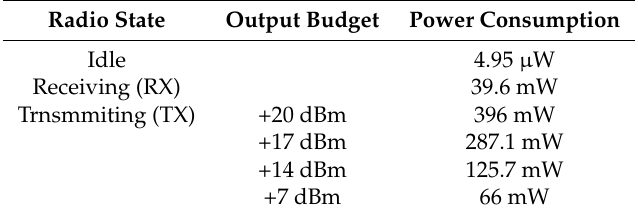
Table 8. Energy Consumption for different states of SX1276 radio.